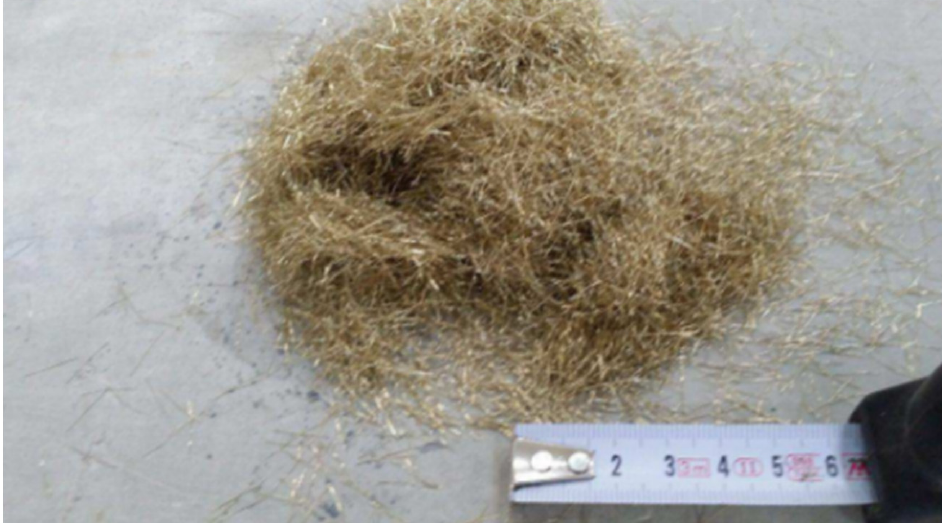
Figure 3. Steel fibres with a length of 13 mm and a diameter of 0.15 mm.